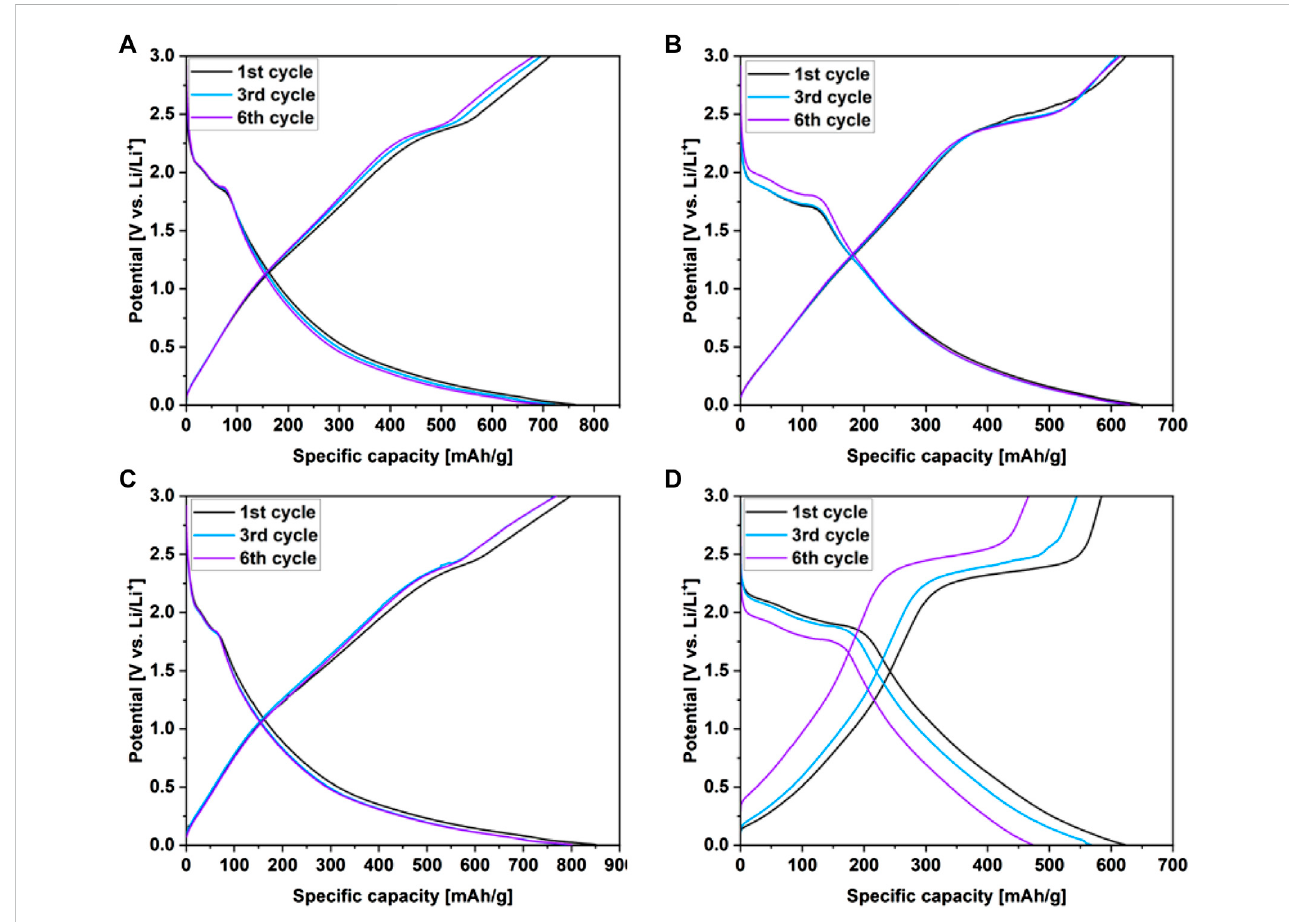
FIGURE 6 Charge/discharge pro fi les recorded over .05 A/g for (A) WS 2 /userGO1, (B) WS 2 /userGO2, (C) WS 2 /userGO3, and (D) ex-WS 2